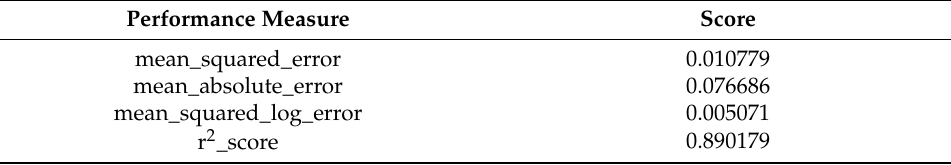
Table 5. Summary of experimental performance measurement indicators (Stage 1).